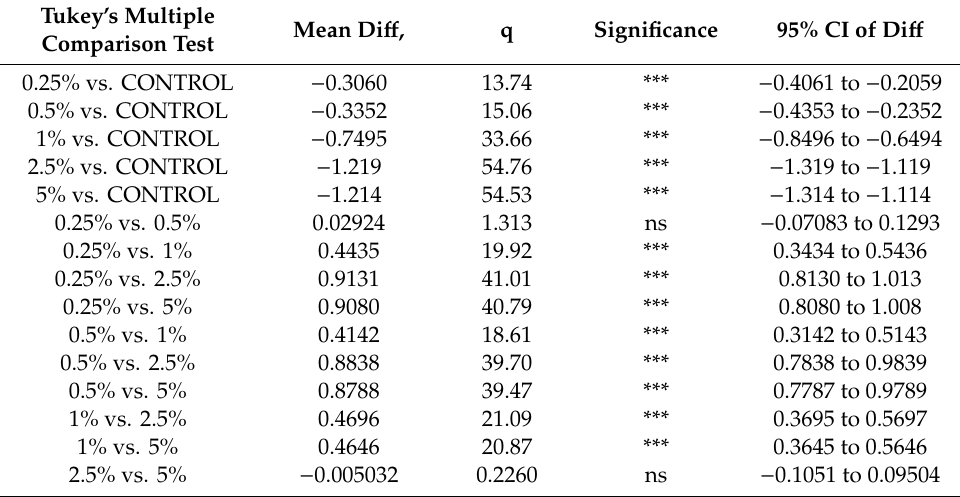
Table 2. Results of Tukey’s test for mouse fibroblasts viability with BioAKT